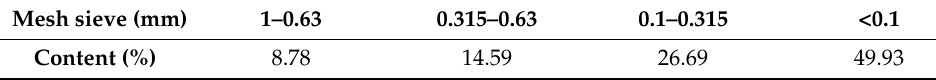
Table A4. Sieve analysis of sifted zinc ash (SZA).